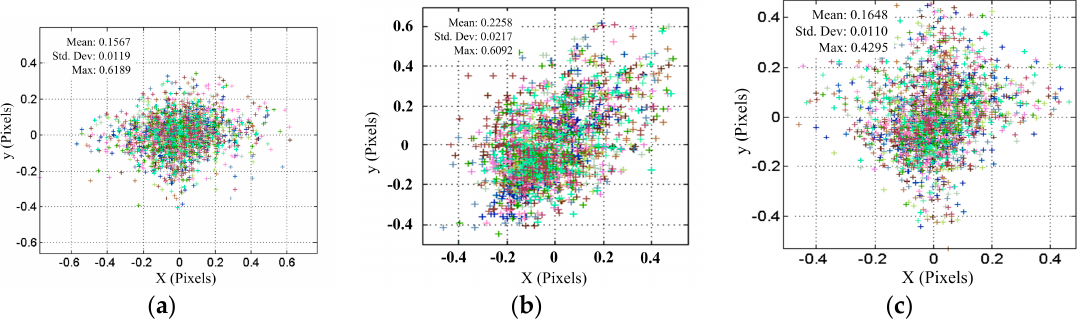
Figure 14. Re-projection errors of the calibration points on the image planes: ( a ) camera; ( b ) out-of-focus projector using the conventional method in [29]; and, ( c ) out-of-focal projector using the proposed method. Table 4. Calibration results of the camera and out-of-focus projector.